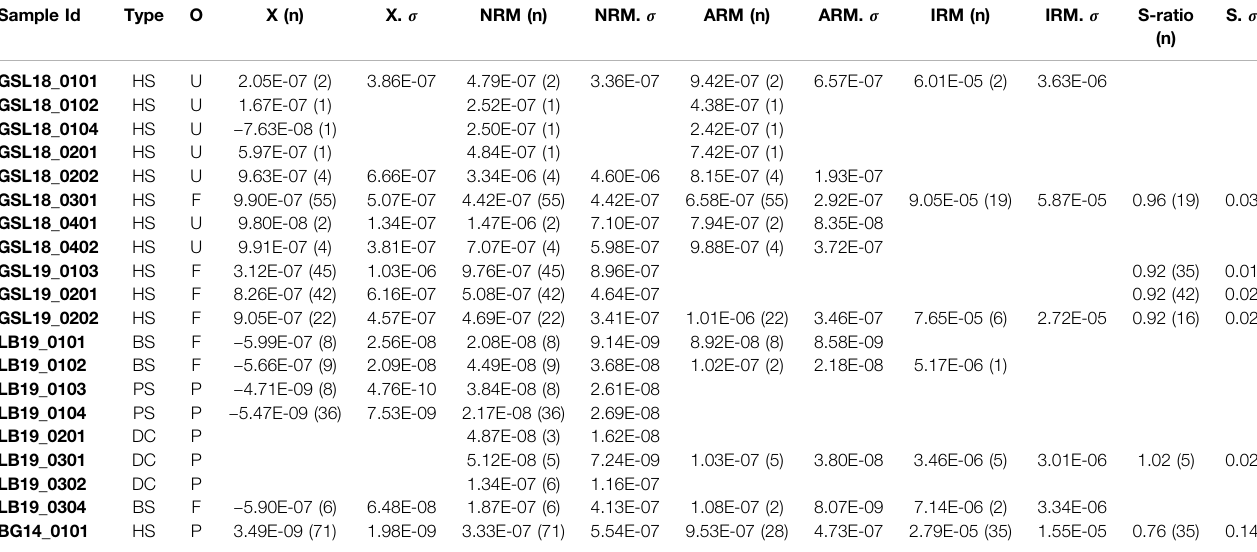
TABLE 2 | Sample types and magnetic properties. Sample